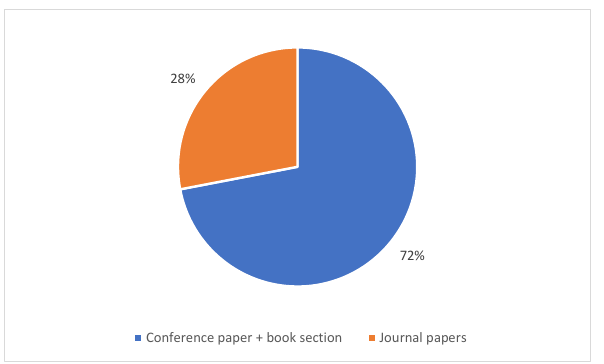
Figure 6. Percentage of papers based on publication type (all = 454).